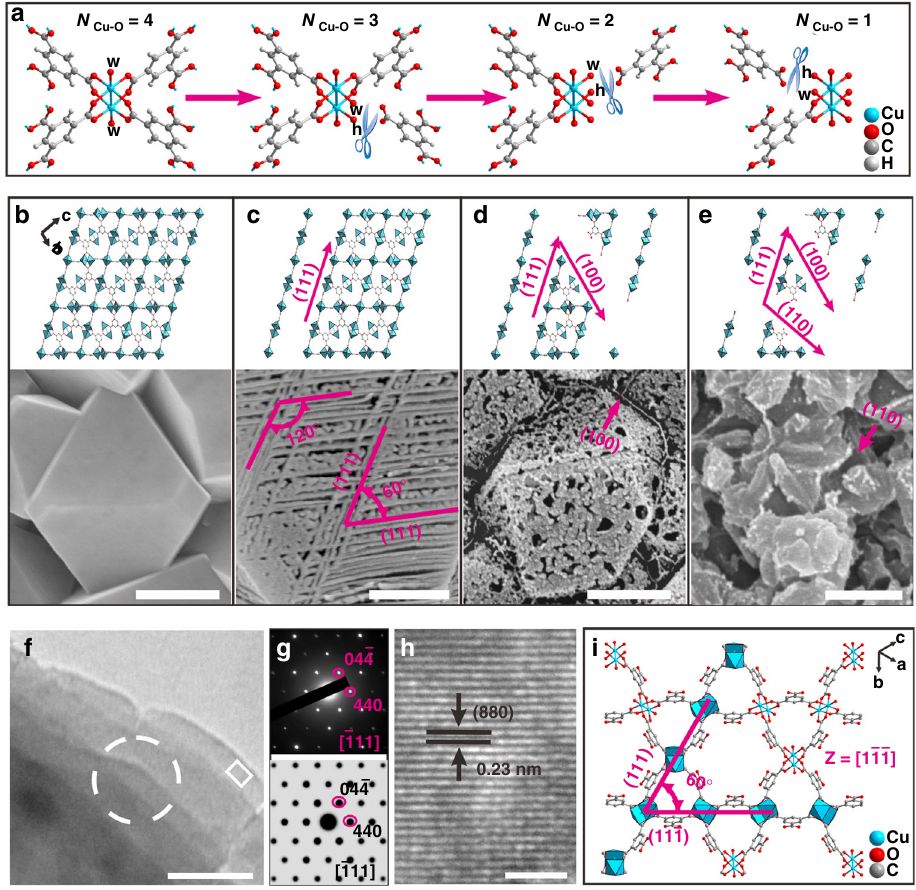
Fig. 2 Synthetic strategy and structural characterisation. a Schematic overview of the etching transformation of four-coordinated Cu atoms to three-, two- and one-coordinated Cu atoms with organic ligands (w represents oxygen atom from the water, and h represents oxygen atom from the hydroxide anion, OH − ). b – e Model structures and real morphologies of the four different MOF crystal states after etching. b Pristine HKUST-1 MOFs, c stacked-nanosheet MOFs, d random-etching MOFs, e collapsed MOFs. f Transmission electron microscopy (TEM) top-view image of a fi ve-layered CASFZU-1 thin nanosheet. g Selected area electron diffraction (SAED) pattern (taken from the white-circled region in f ) at the top shows diffraction within a few-layered nanosheet. A simulated SAED pattern of the HKUST-1 crystal down the ½ (cid:1) 111 (cid:2) axis is also shown. h High-resolution TEM (HR-TEM) image of the white-framed region at the edge of the nanosheet shown in f . i The crystal structure of HKUST-1 along the ½ 1 (cid:1) 1 (cid:1) 1 (cid:2) direction. Scale bars represent 500 nm for b , d , and e , 200 nm for d , 100 nm for f and 2 nm for h . Colour scheme for chemical representation: cyan, Cu; red, O; grey, C; white,